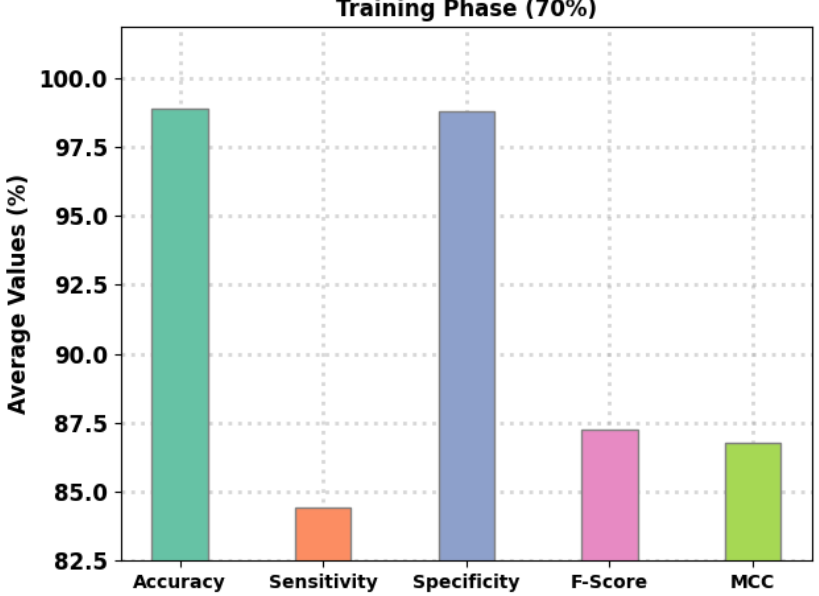
Figure 6. Average analysis of the RFER-EADL algorithm under 70% of TR dataset. Figure 7 exemplifies the FER results of the RFER-EADL on 30% of the TS dataset. The outcomes denoted by the RFER-EADL approach recognized all facial expressions precisely.